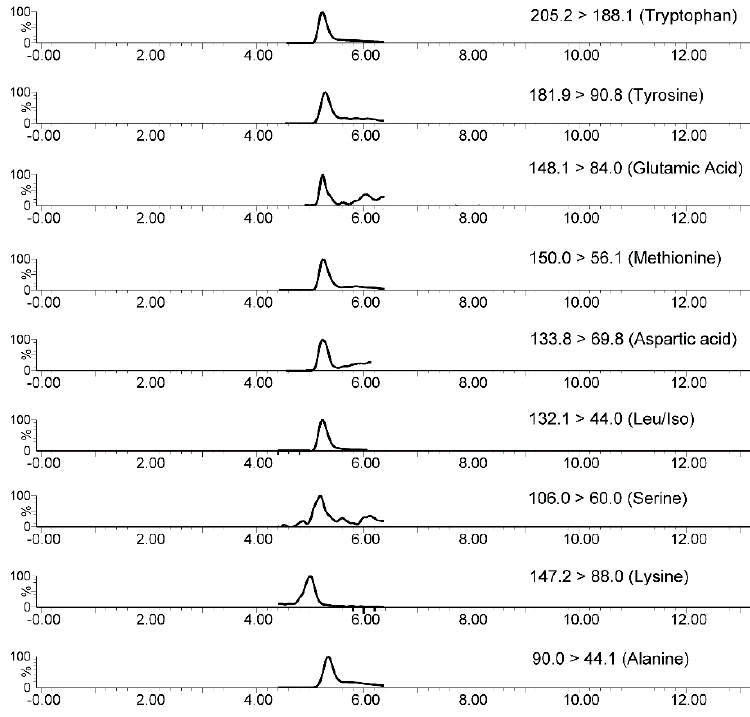
Figure 6. Representative in-tube SPME-MS / MS (SRM mode) chromatogram of plasma sample from a schizophrenic patient. Plasma concentrations: alanine = 243.7 nmol mL − 1 ; serine = 155.1 nmol mL − 1 ; leu / Iso = 199.9 nmol mL − 1 ; aspartic acid = 13.5 nmol mL − 1 ; methionine = 9.6 nmol mL − 1 ; tyrosine = 35.9 nmol mL − 1 ; tryptophan = 32.1 nmol mL − 1 ; glutamic acid = 30.9 nmol mL − 1 ; and lysine = 21.7 nmol mL − 1 .